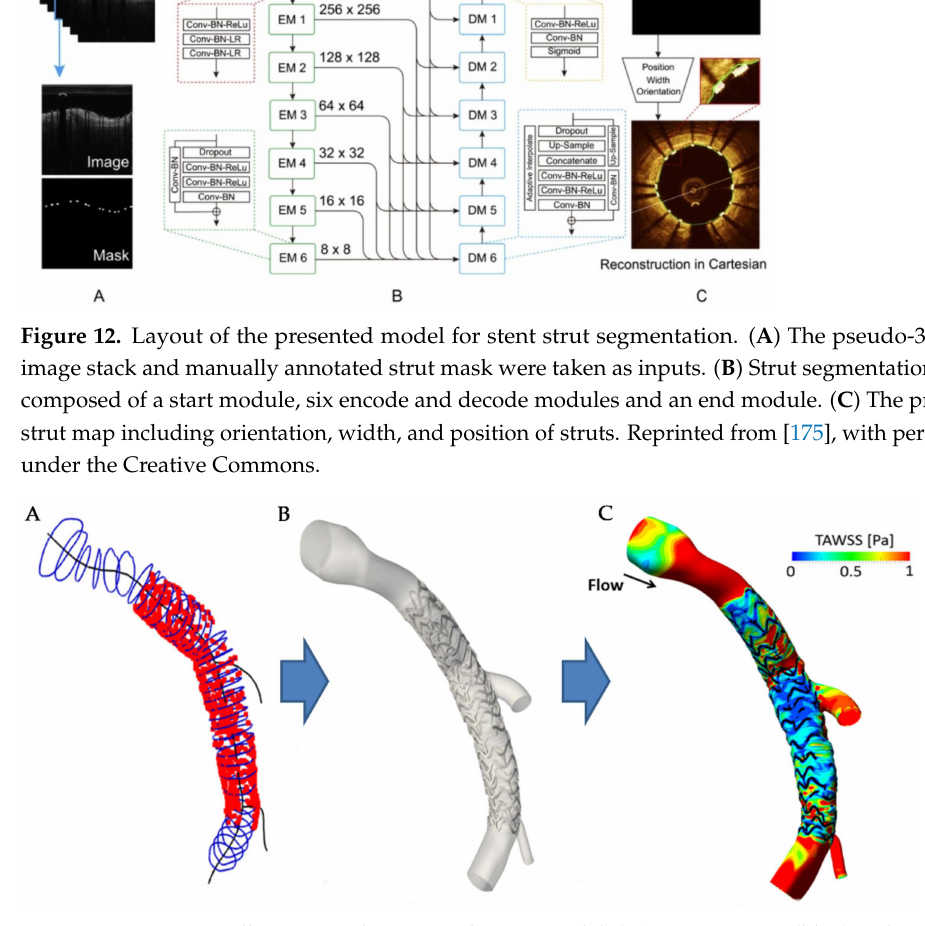
Figure 13. Automatically generated 3D stented artery model. ( A ) OCT contours (blue) and stent struts (red) placed along the 3D centerline (black). ( B ) Generated 3D surface model. ( C ) Wall shear stress resulting from CFD simulation. Reprinted from [64], with permission, under the Creative